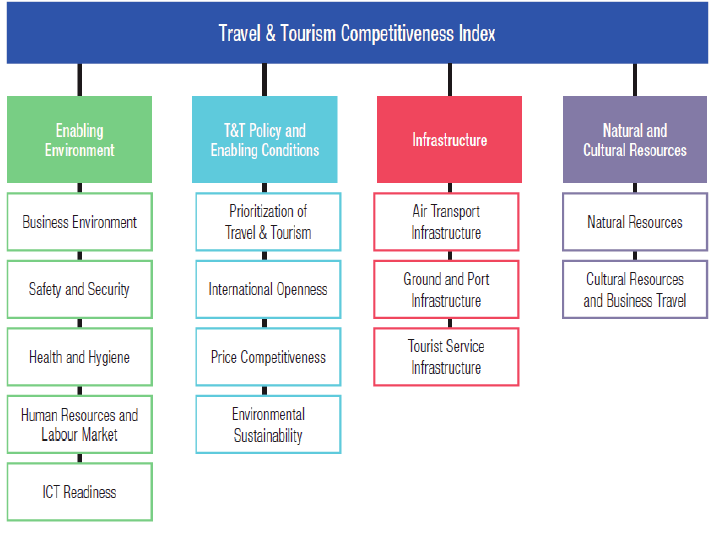
Fig. 1 - The structure of the latest (2015) Travel and Tourism Competitiveness Index Source: WEF Travel and Tourism Competitiveness Index